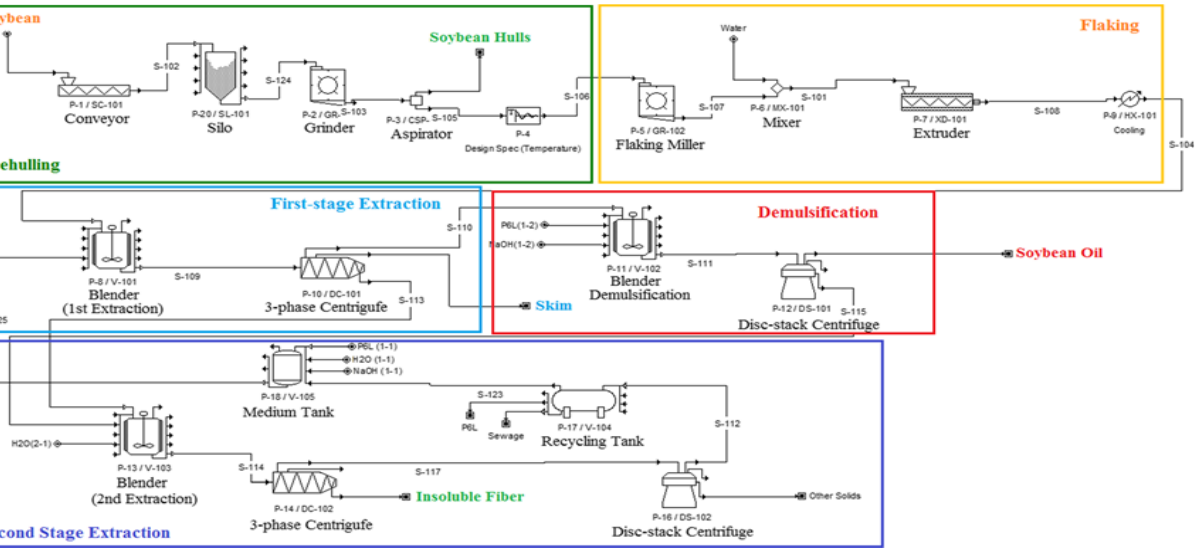
Figure 18. Flow diagram of techno-economic analysis model of enzyme-assisted aqueous extraction process for soybean oil extraction [201]. Reproduced with permission of Cheng et al., 2019 (ref. [201]). Copyright 2019, Springer Science Business Media, LLC, part of Springer Nature.